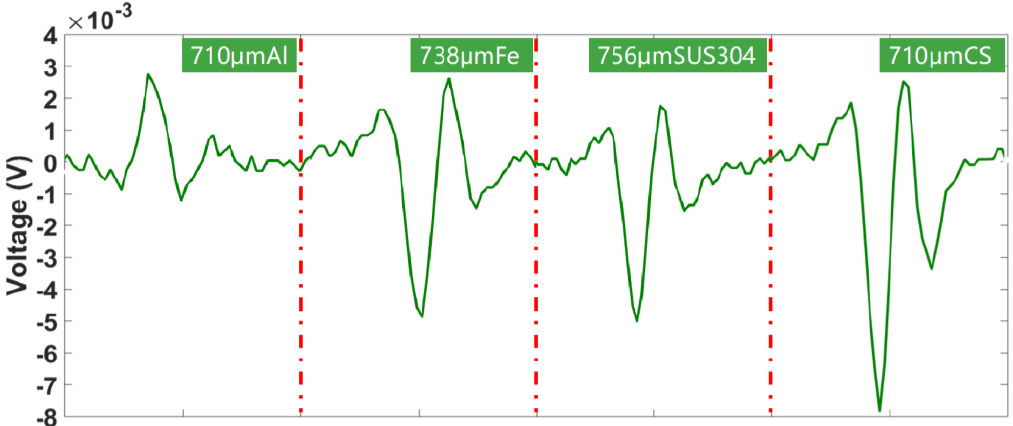
Figure 6. Inductive electric potential generated by particles of different materials.